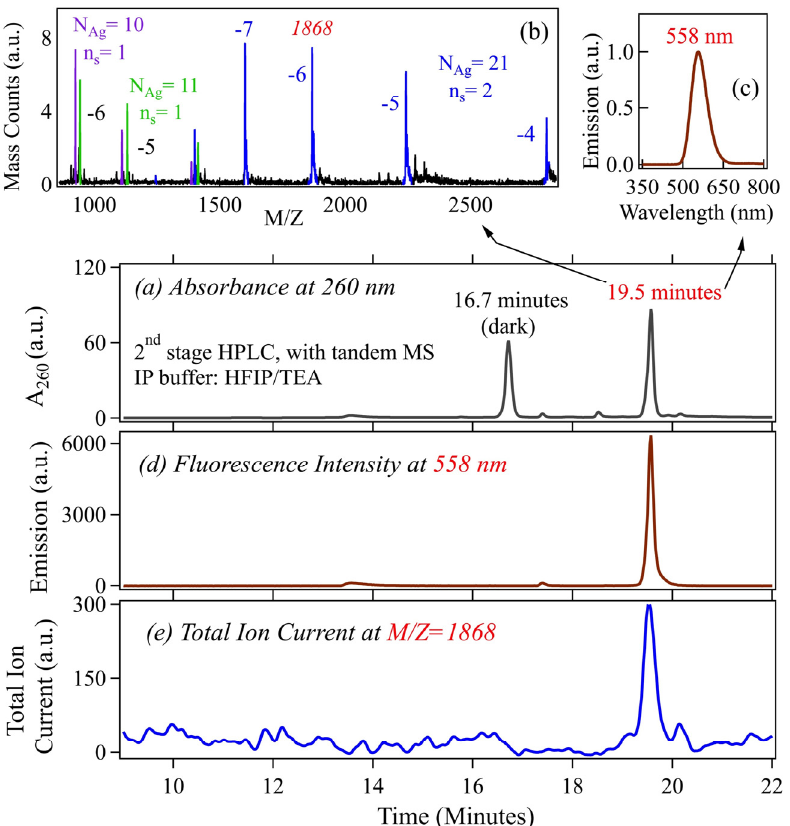
Figure 3. Identification of the composition of a weakly-bound strand dimer ( n s = 2) Ag N -DNA. Chromatograms are from the 2nd stage of HPLC purification (HFIP/TEA) with inline MS. Reprinted with permission from reference [28]. ( a ) A 260 peaks for elution of all DNA-containing species. The fluorescent Ag N -DNA elutes at 19.5 minutes; ( b , c ) MS and emission spectra corresponding to the 19.5 min A 260 peak in ( a ); ( b ) The Z = − 4, − 5, number of DNA strands. The additional strand monomer peaks correspond to n s = 1 and equal within experimental error); ( d ) Fluorescence chromatogram at 558 nm; and ( e ) Mass chromatogram of the N Ag = 21, n s = 2 IR emitter, for M / Z =